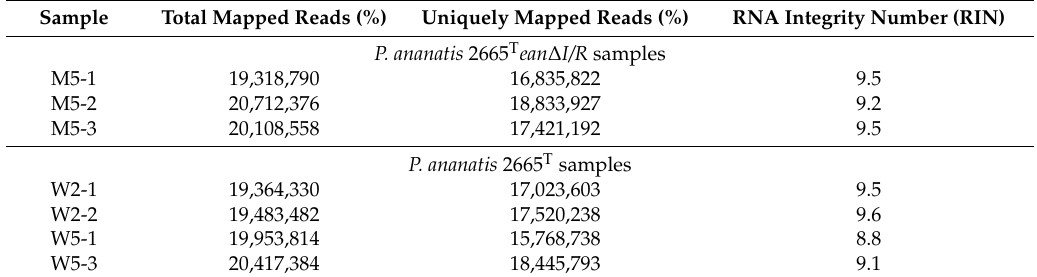
* Samples M5-1, M5-2 and M5-3 represent biological replicates for RNA isolated from 2665 T ean ∆ I/R at OD 600 = 0.5. Samples W2-1, W2-2 represent biological replicates for RNA samples isolated from 2665 T at OD 600 = 0.2, samples W5-1, W5-3 are biological replicates for RNA isolated at OD 600 = 0.5 from 2665 T . OD: Optical density; M: Mutant; W: